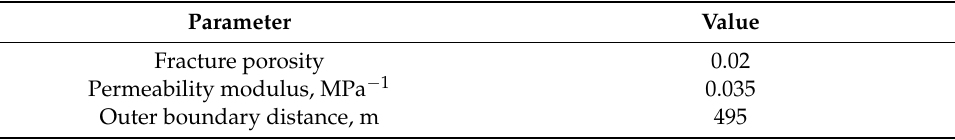
Figure 8. Interpretation and prediction of the production decline in the example wells. Table 3. Matching Interpretation Results of Example